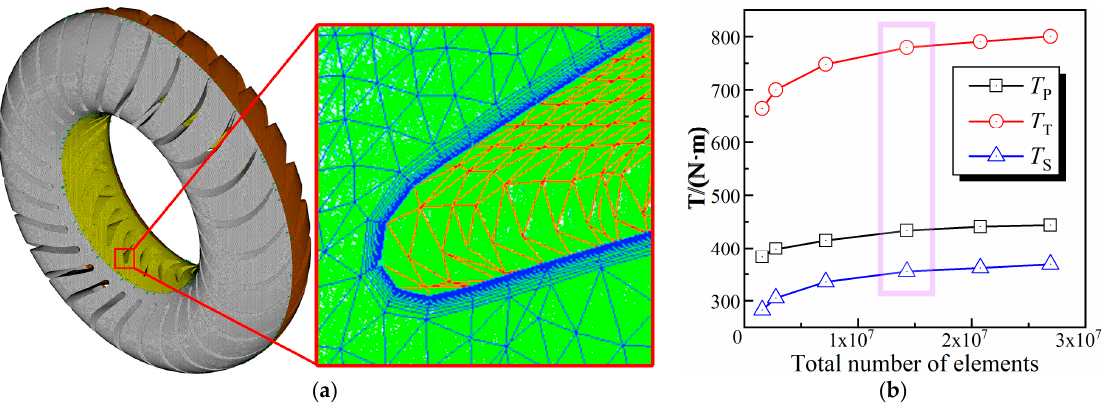
Figure 3. Mesh model and independence analysis results of torque converter. ( a ) The full flow mesh model and the refined mesh of the blade. ( b ) Mesh independence analysis.